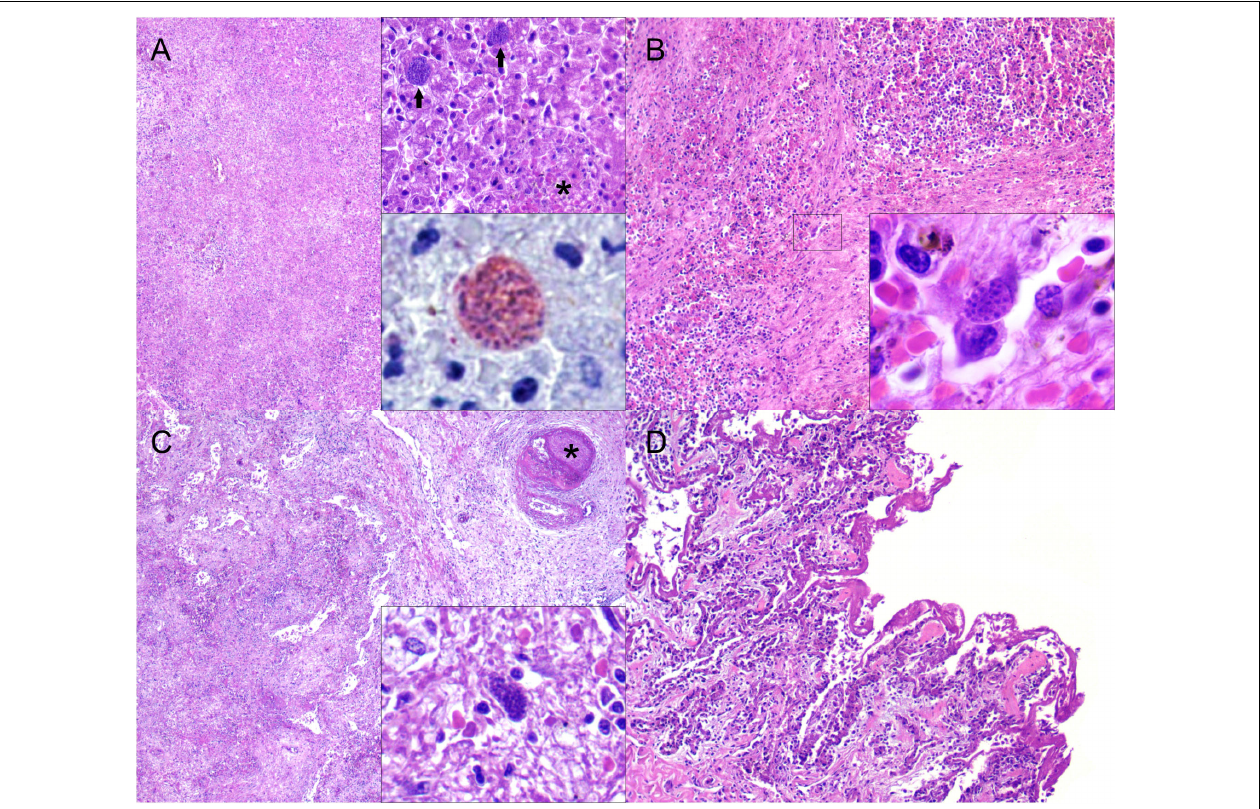
FIGURE 2 | Microscopic findings in a Bryde’s whale ( Balaenoptera edeni ) with disseminated toxoplasmosis. (A) Liver: marked, multifocal random to coalescing, acute necrotizing hepatitis. H&E, × 40. Right upper inset: focus of necrotizing hepatitis (asterisk) and two adjacent protozoal cysts (arrows). H&E, × 400. Right lower inset: protozoal cysts immunolabeled by anti- Toxoplasma gondii antibody. Immunohistochemistry, × 1,000. (B) Spleen: fibrinous exudate and necrotic cell debris along with loss of cellular detail and hemorrhage. H&E, × 100. Inset: detail of intracytoplasmic endothelial protozoal cyst. H&E, × 1,000. (C) Pulmonary lymph node: necrotizing lymphadenitis with extensive lymphoid loss and focal capsular obliterative fibrinocellular thrombus (asterisk). H&E, × 40. Inset: intracellular protozoal cyst amidst fibrinonecrotizing inflammation. H&E, × 40. (D) Lung: abundant fibrin layers coating the alveolar septa with necrotic pneumocytes and inflamed septa. H&E, ×